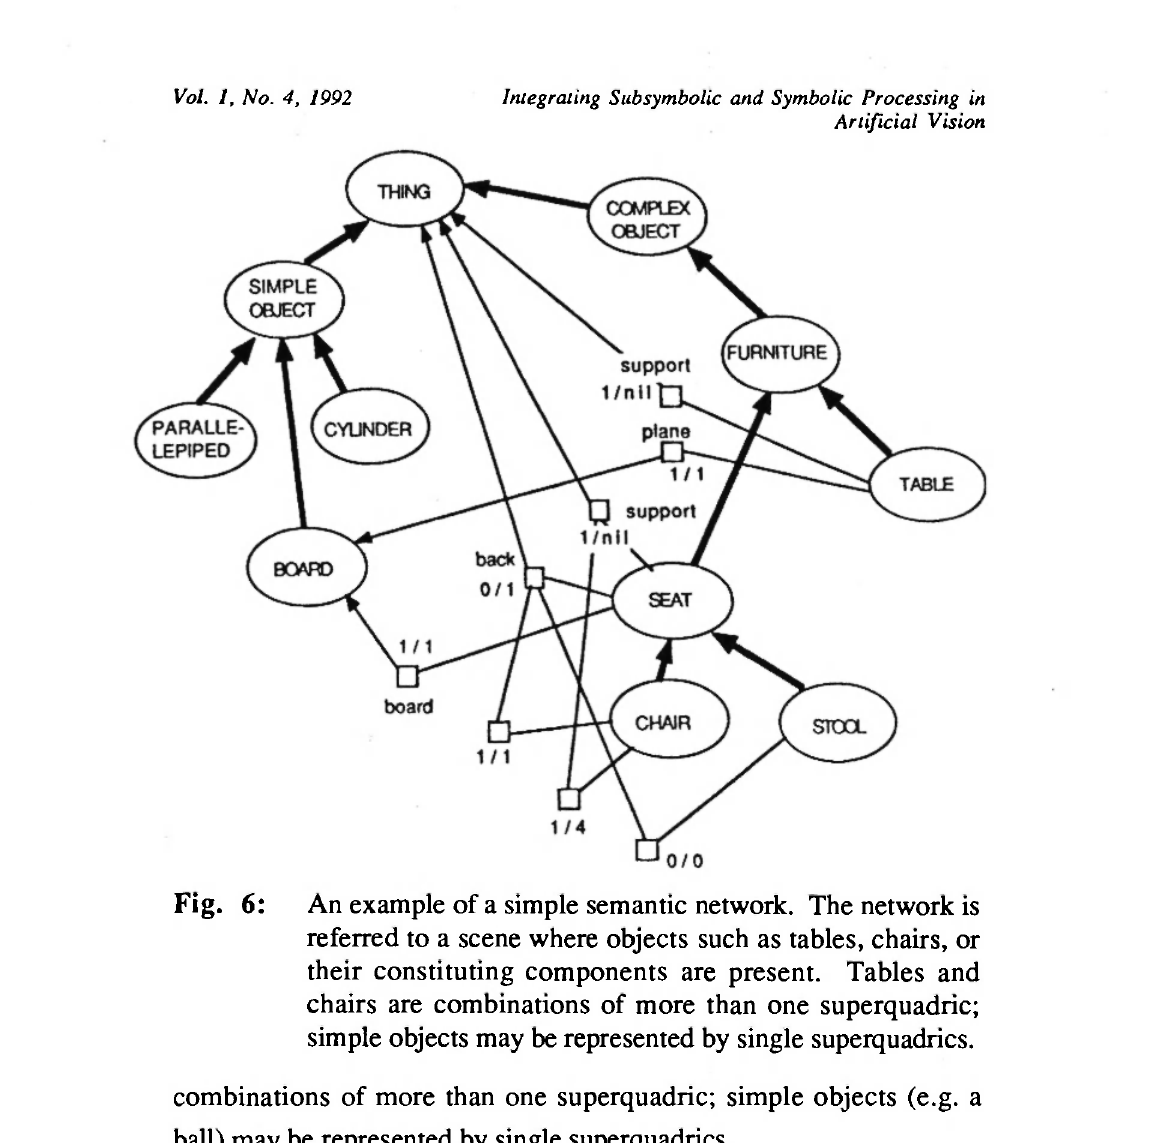
Fig. 6: An example of a simple semantic network. The network is referred to a scene where objects such as tables, chairs, or their constituting components are present. Tables and chairs are combinations of more than one superquadric; simple objects may be represented by single